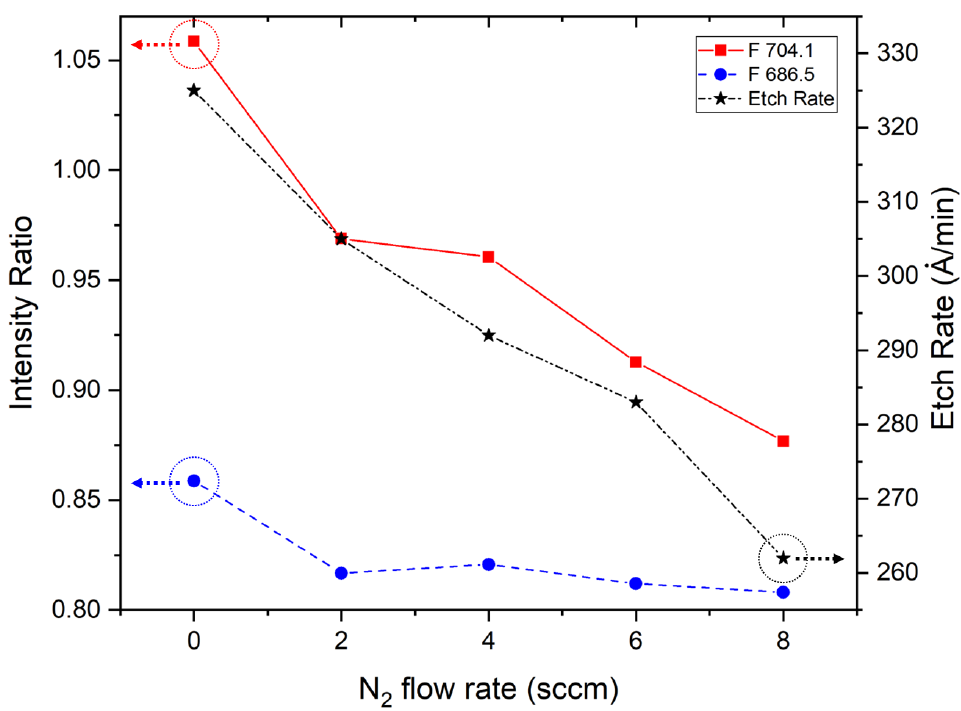
Figure 8. Trends of the F actinometry results versus the etch rate of Si 3 N 4 .